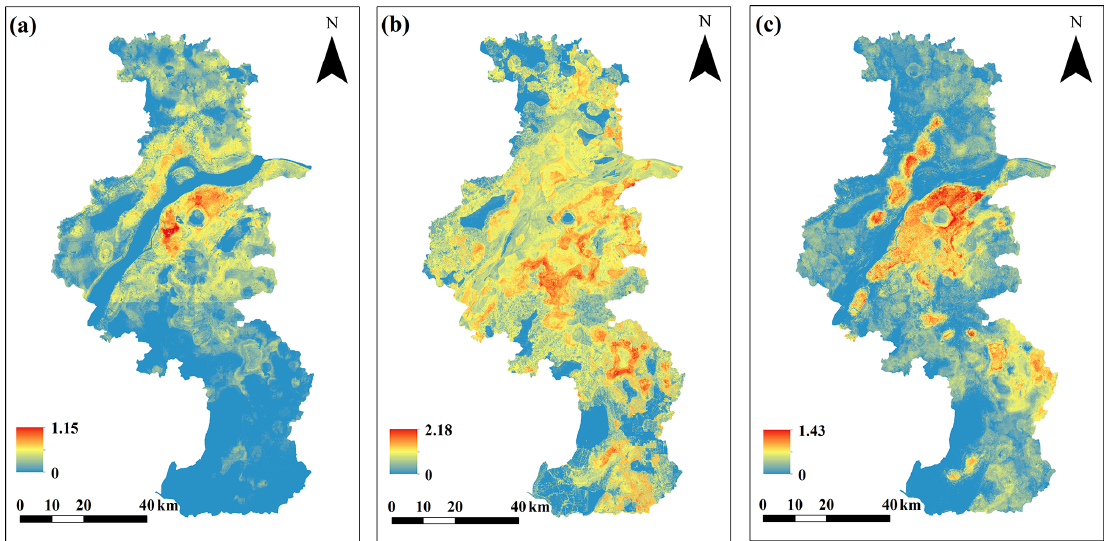
Figure 15. Spatial distribution of canopy urban heat island intensity (CUHII) in Nanjing during a heatwave period: (a) 12 August 2013; (b) 13 August 2013; (c) 14 August